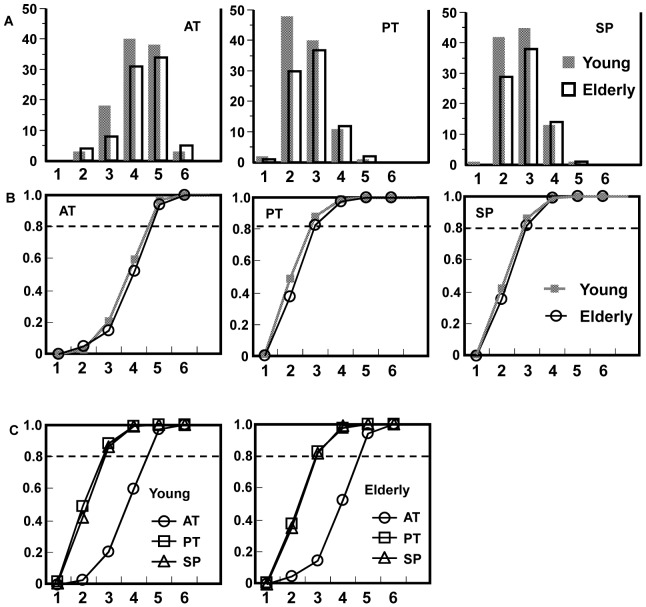
Distribution of umami taste sensitivity in healthy young and older persons at three different measurement sites.The abscissae shows the concentrations of the aqueous MSG solutions (1, 1 mM; 2, 5 mM; 3, 10 mM; 4, 50 mM; 5, 100 mM; 6, 200 mM). The ordinates shows the number of participants who correctly recognized MSG at each concentration of MSG (A), and the proportion of the participants who correctly recognized MSG the at each MSG concentration (B and C).